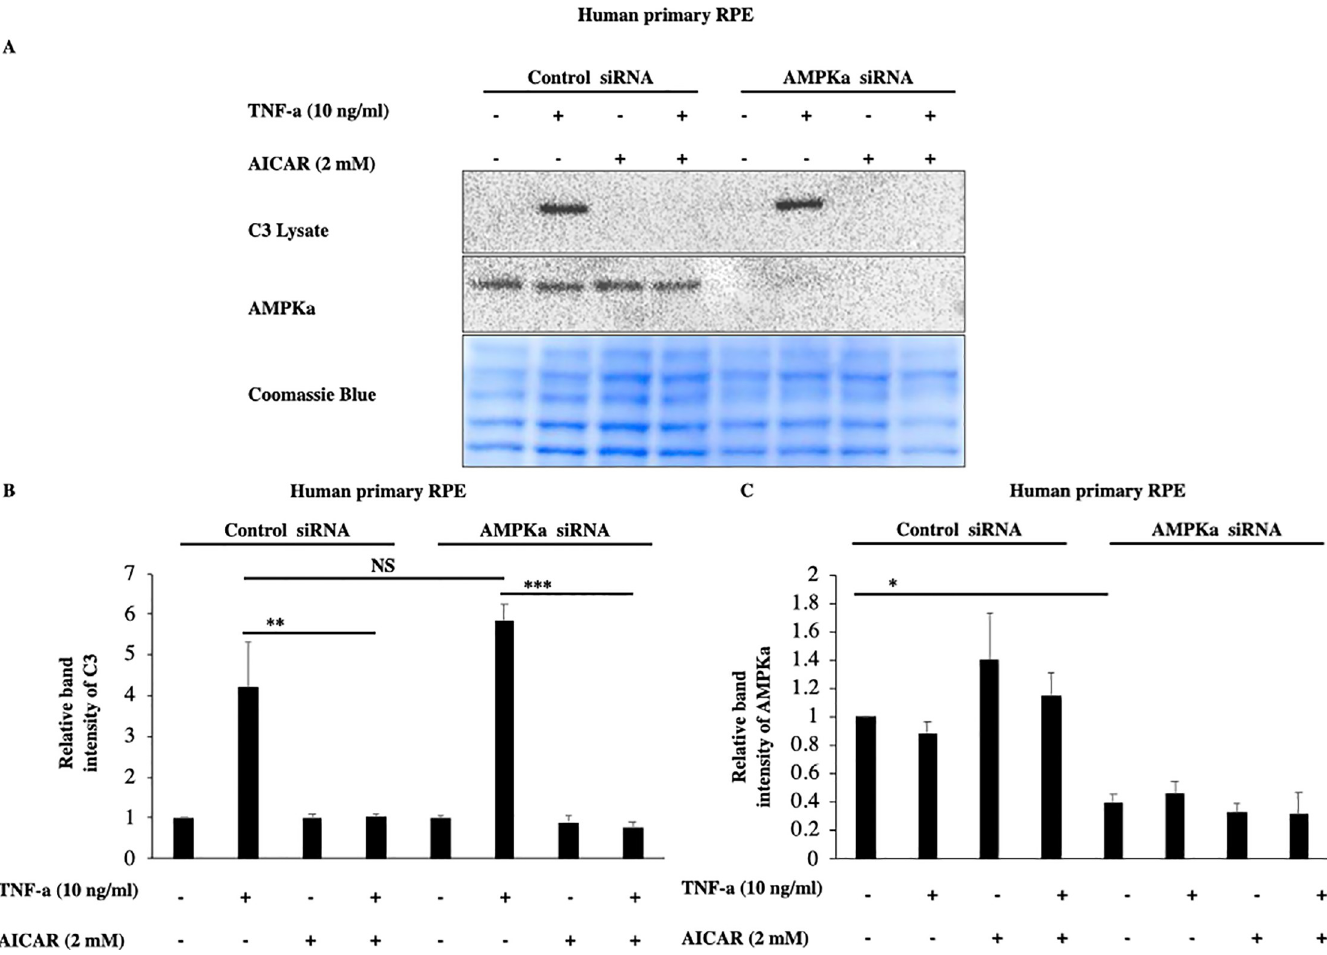
Fig 4. Silencing of AMPK α expression by siRNA in RPE cells did not affect the inhibitory effects of Acadesine on TNF- α induced C3 expression. The third day after transfection with either non-targeting control siRNA or AMPK α 1 and AMPK α 2 siRNA medium was replaced with fresh serum free medium. 24 hours after serum depletion pRPE cells were treated with acadesine (2mM) for 1 hour before stimulation with TNF- α (10ng/ml) for additional 24 hours. TNF- α induced C3 levels were similar in both groups. AMPK α knockdown did not abolish the inhibitory effect of acadesine in TNF- α induced C3 expression as seen in A. Western blot representing the expression levels of C3 in transfected human primary RPE cell lysates. B. Densitometry analysis of C3 protein levels in transfected human primary RPE cells. C. Densitometry analysis of AMPK α levels in human primary RPE cells showing significant reduction in protein expression in cells transfected with AMPK α 1+ AMPK α 2 siRNA compared with those transfected with non-targeting control